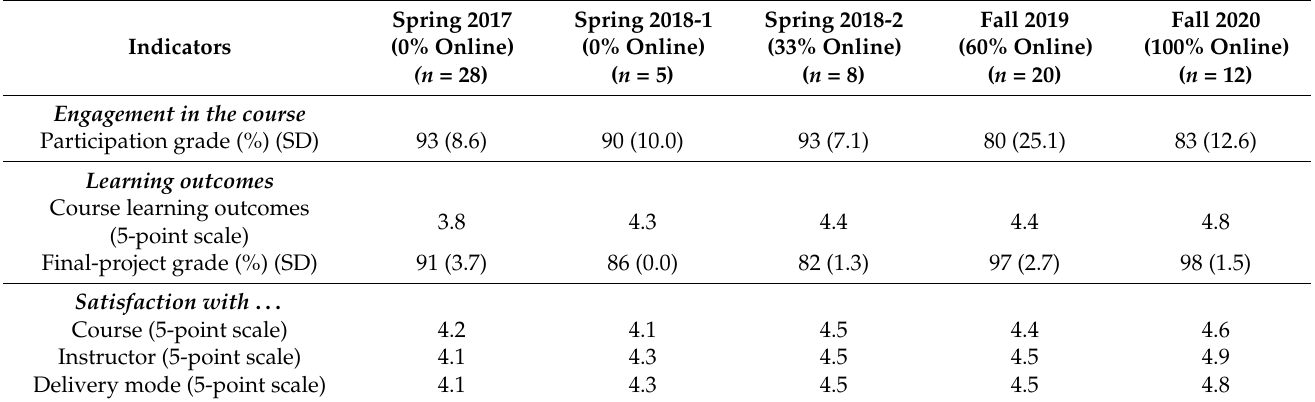
Table 1. Impact indicators of e-service learning